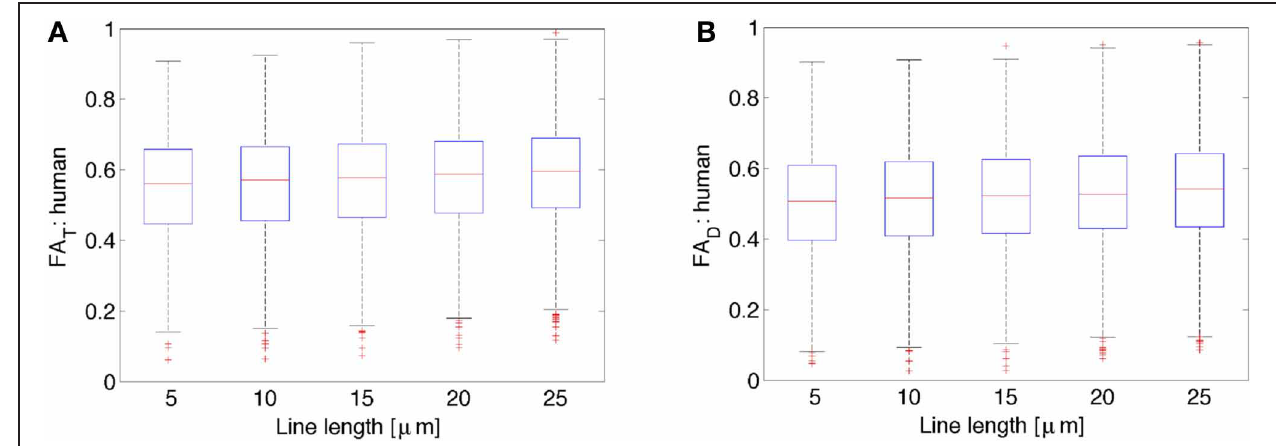
there is a slight increase in both FA T as well as FA D with increases in line length, these data suggest that there is very little variation in both FA T and FA D due to differences in line length used to represent the